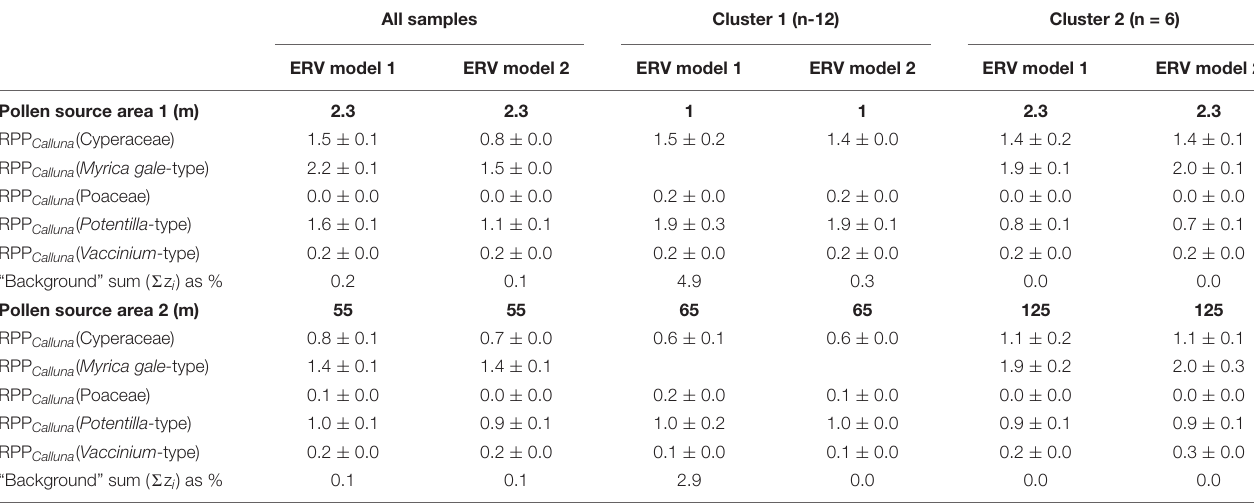
TABLE 3 | Estimates of Pollen Productivity relative to Calluna vulgaris produced by this study (see also Figure 7